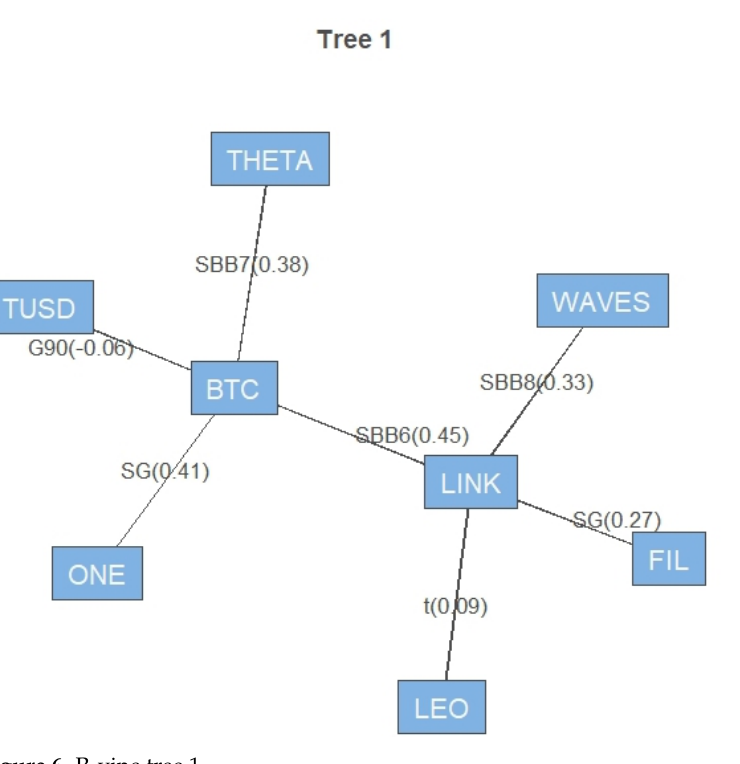
Figure 6. R-vine tree 1.